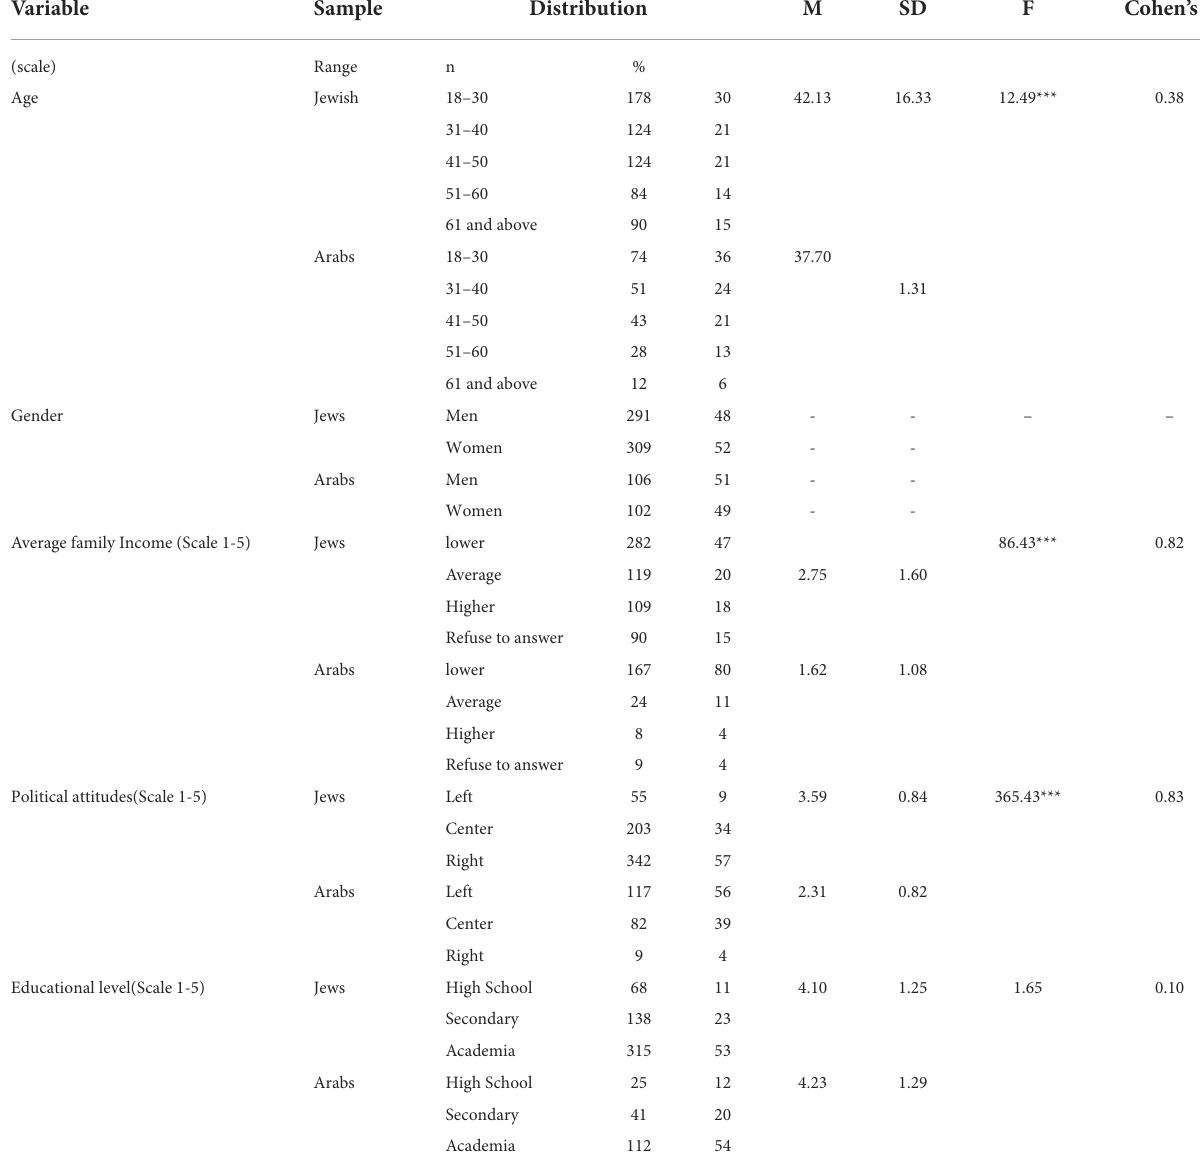
TABLE 1 Demographic characteristics and analysis of variance (ANOVA) comparing mean scores of Jewish ( N = 600) and Arab sample ( N = 208).